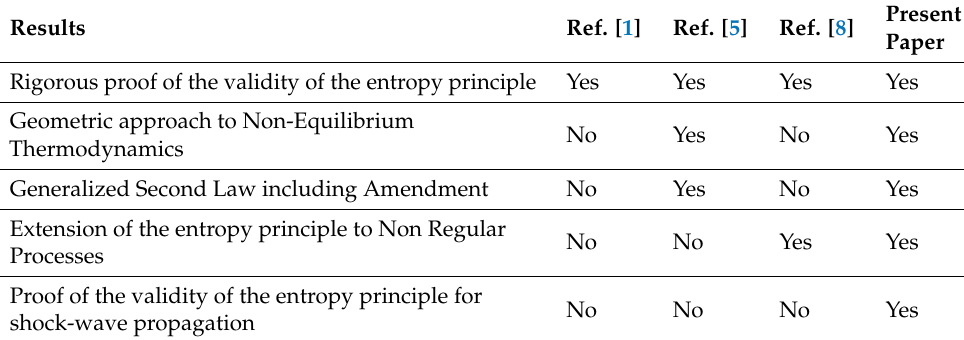
Table 1. Comparison of the results in [1,5,8] with the results obtained in the present paper.